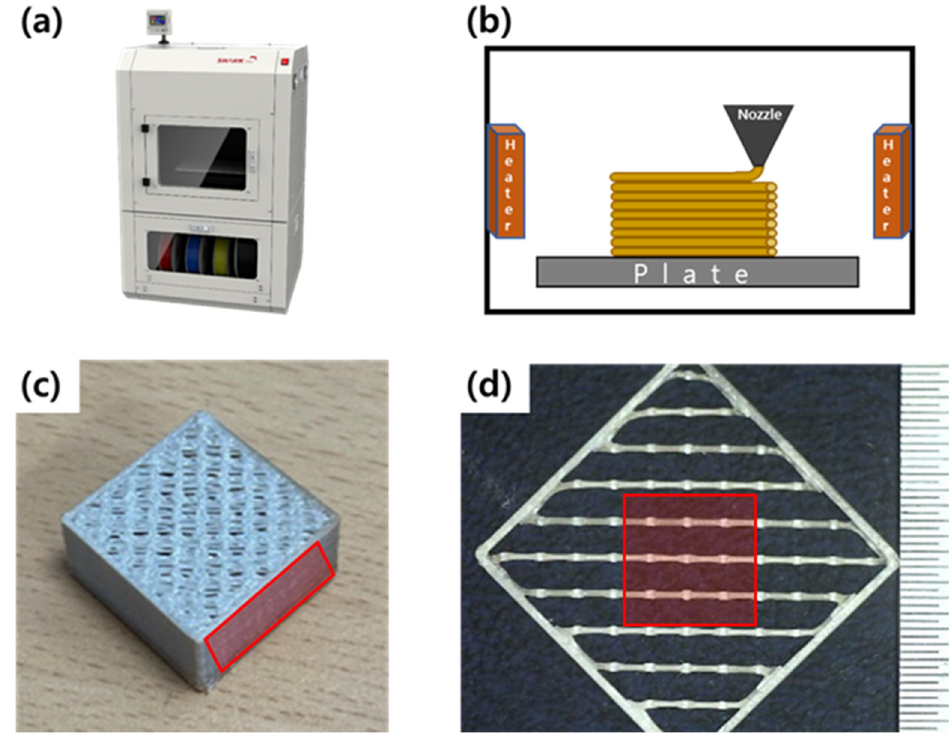
Figure 1. Specimens for measurement line width: ( a ) fused filament fabrication (FFF) system, ( b ) scheme of 3D printing process, ( c ) 3D Printed PEEK, and ( d ) mono-layer between PEEK printed lines.